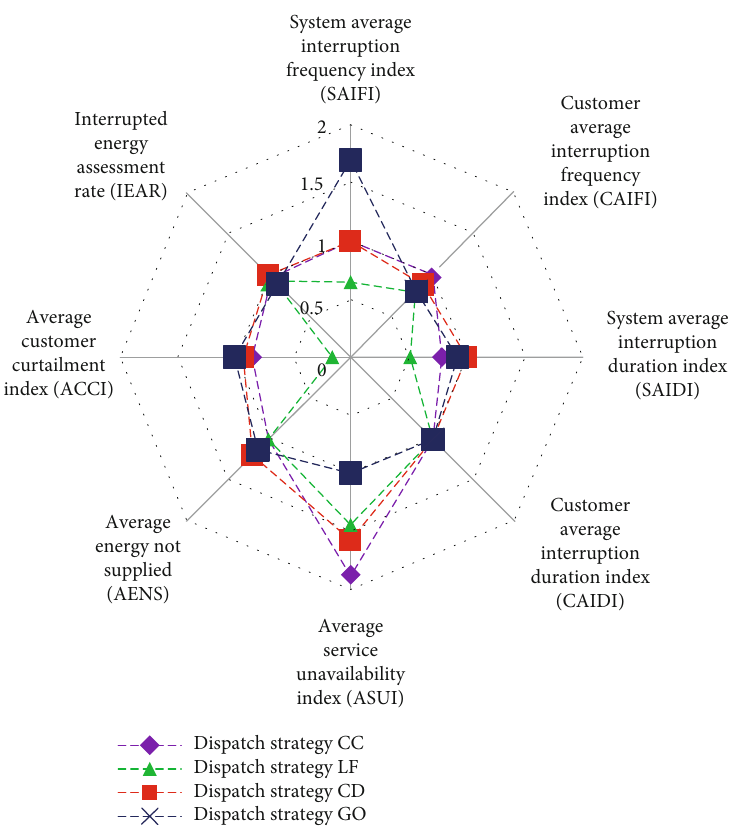
Figure 8: The reliability index for the designed o ff -grid microgrid. This fi gure is reproduced from Shezan et al. [5].